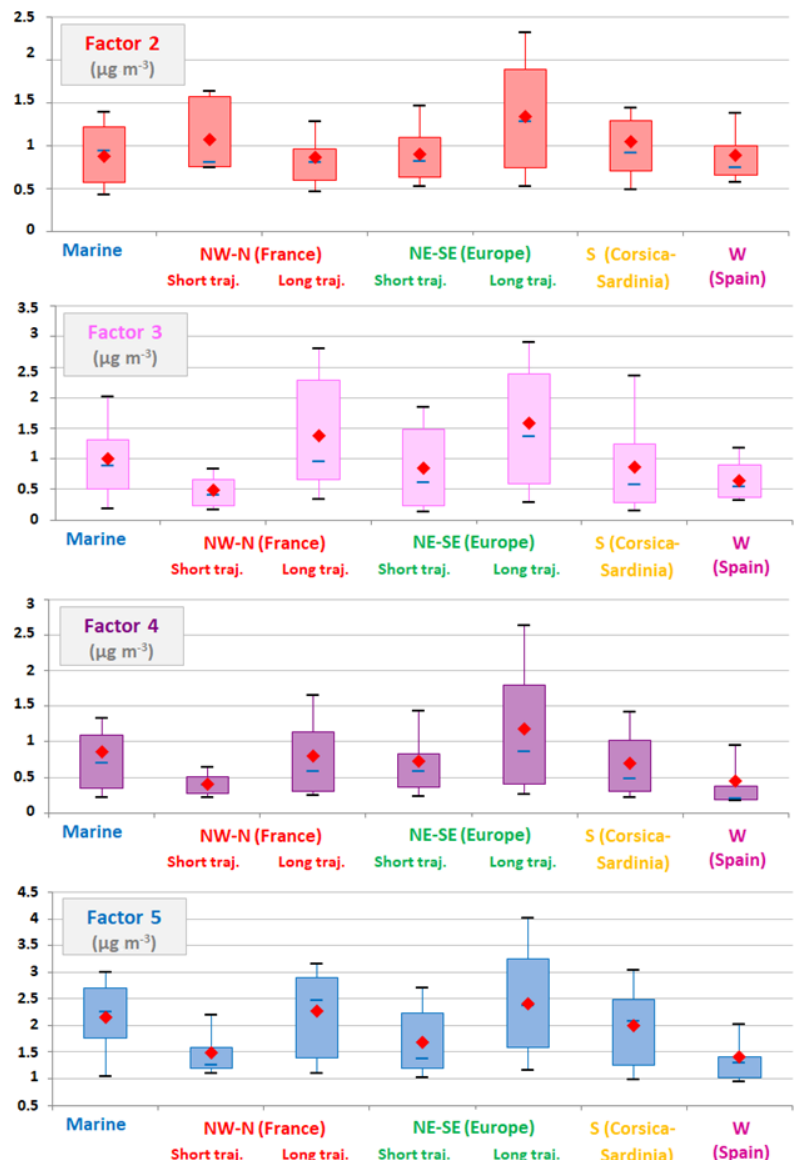
Figure 9. NMHC factor contributions (µgm − 3 ) as a function of air-mass origin represented by box plots; the blue solid line, the red marker, and the box represent the median, the mean, and the interquartile range of the values, respectively. The bottom and top of the box depict the first and third quartiles and the ends of the whiskers correspond to the first and ninth deciles. Factor 2 – short-lived anthropogenic sources; factor 3 – evaporative sources; factor 4 – long-lived combustion sources; factor 5 – regional background. Air masses originating from France and Europe are subdivided into short and long trajectories to highlight local and more distant contributions (see Sect. 3.2). Note that the NMHC dataset used for the PMF analysis included different sampling time hours (09:00–13:00 or 12:00–16:00UTC) following shifts during the 2-year period (see Table